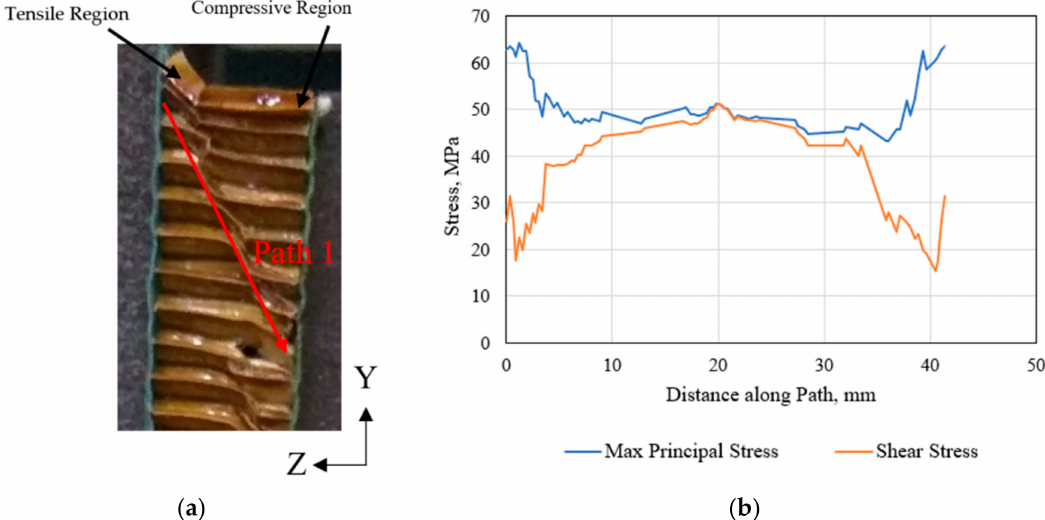
Figure 15. ( a ) Failed polymer hexagonal HC core specimen under the out-of-plane transverse shear, and ( b ) the correspond- ing FE-calculated principal stress and shear stress in the HC core model.